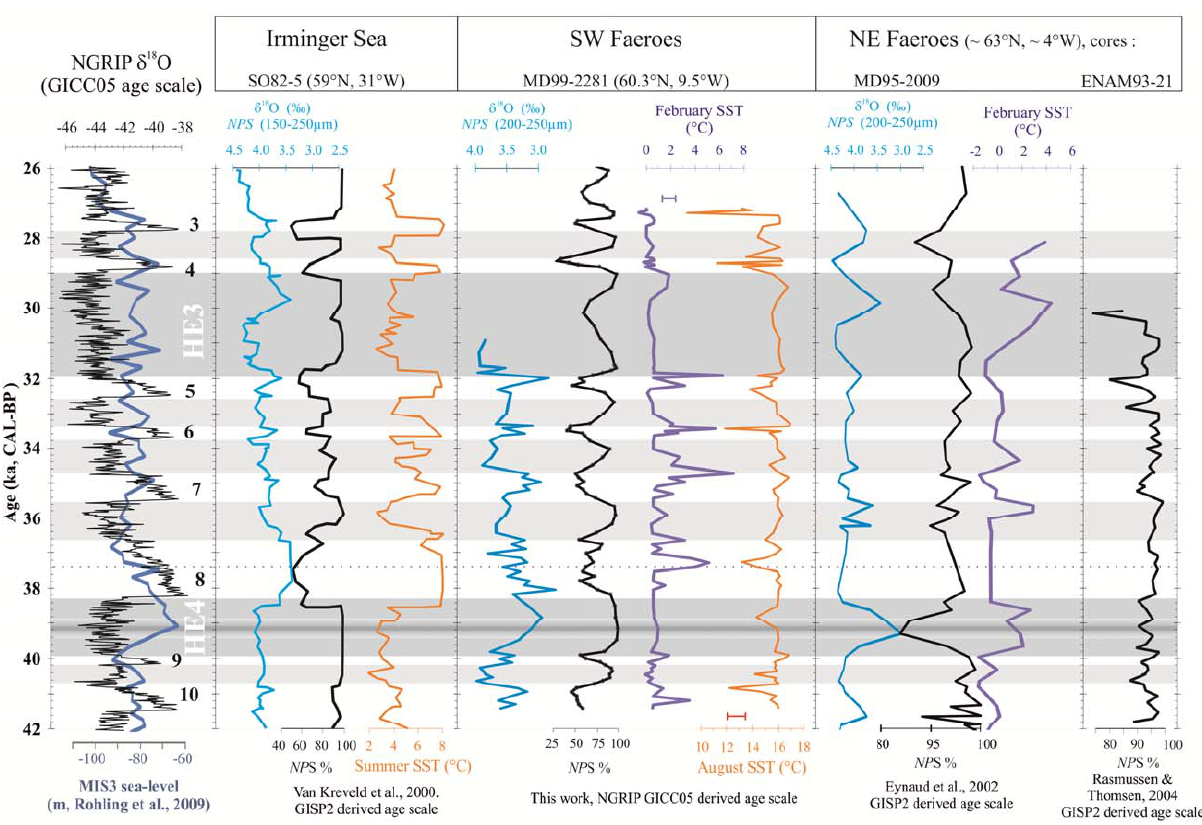
Figure 7 Fig. 7. Compilation of comparable MIS3 marine records from the subpolar North Atlantic (see Fig. 1 for the location of the cores), including core SO82-5 (Van Kreveld et al., 2000), core MD99-2281 (this work), core MD95-2009 (Eynaud et al., 2002) and core ENAM93-21 (Ras- mussen and Thomsen, 2004). Proxies from the same nature are shown with the same colour. A reconstruction of the MIS3 sea-level (m) is also shown on the left (Rohling et al., 2009; Siddall et al., 2006). Grey bands: same legend as Fig.